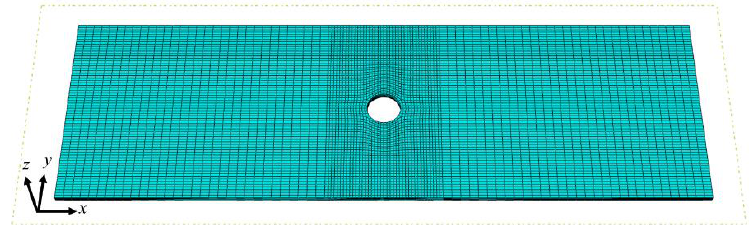
Figure 8. The FE model of the specimen.